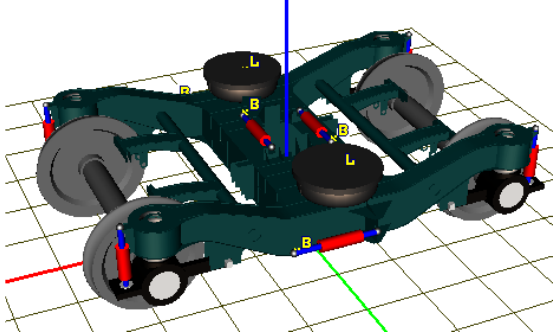
Figure 8. Bogie model.